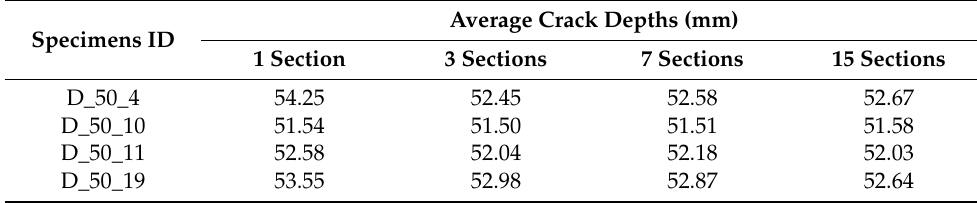
Table 4. Average crack depth to the number of section images.